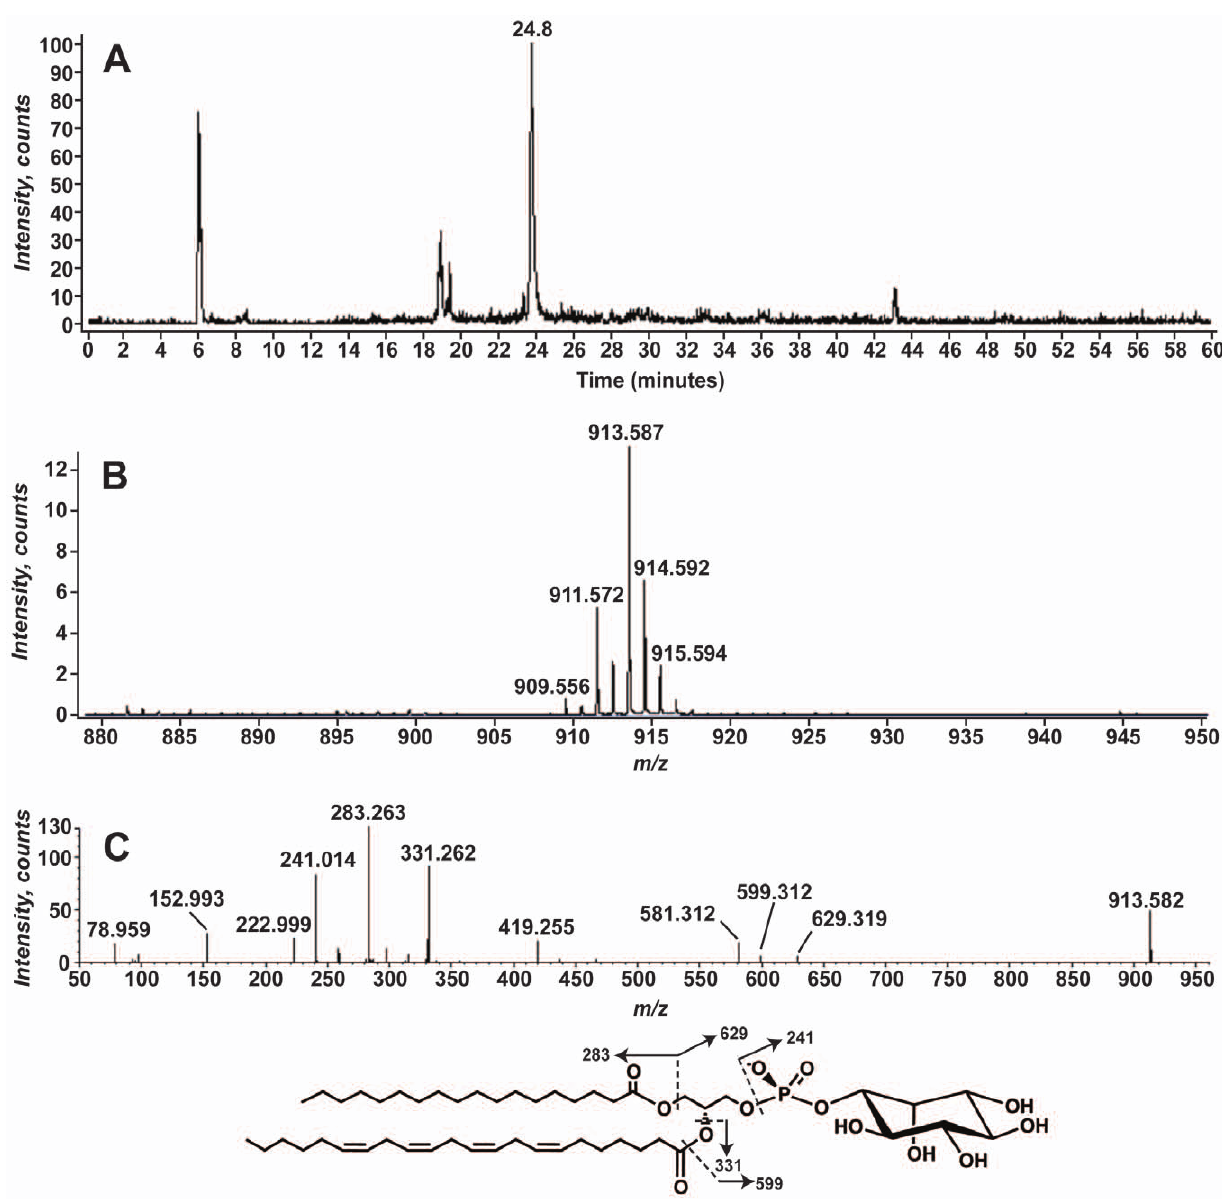
Figure 3. Phosphatidylinositol identified in aposymbiotic A.pallida total lipid extracts. The total lipid extracts from aposymbiotic A. pallida were analyzed using normal phase liquid chromatography mass spectrometry (LC-MS) detecting negative ions. The extracted ion current (EIC) for m/z 913.5, the mass of 40:4 PI is shown in Panel A. Panel B shows the mass spectrum from m/z 880 to 950 for the lipids eluting between 23.6 and 24.0 minutes. The MS/MS spectrum of m/z 913.5 is shown in Panel C. The structure of the predominant PI molecular species and the predicted product ions is shown below panel C.